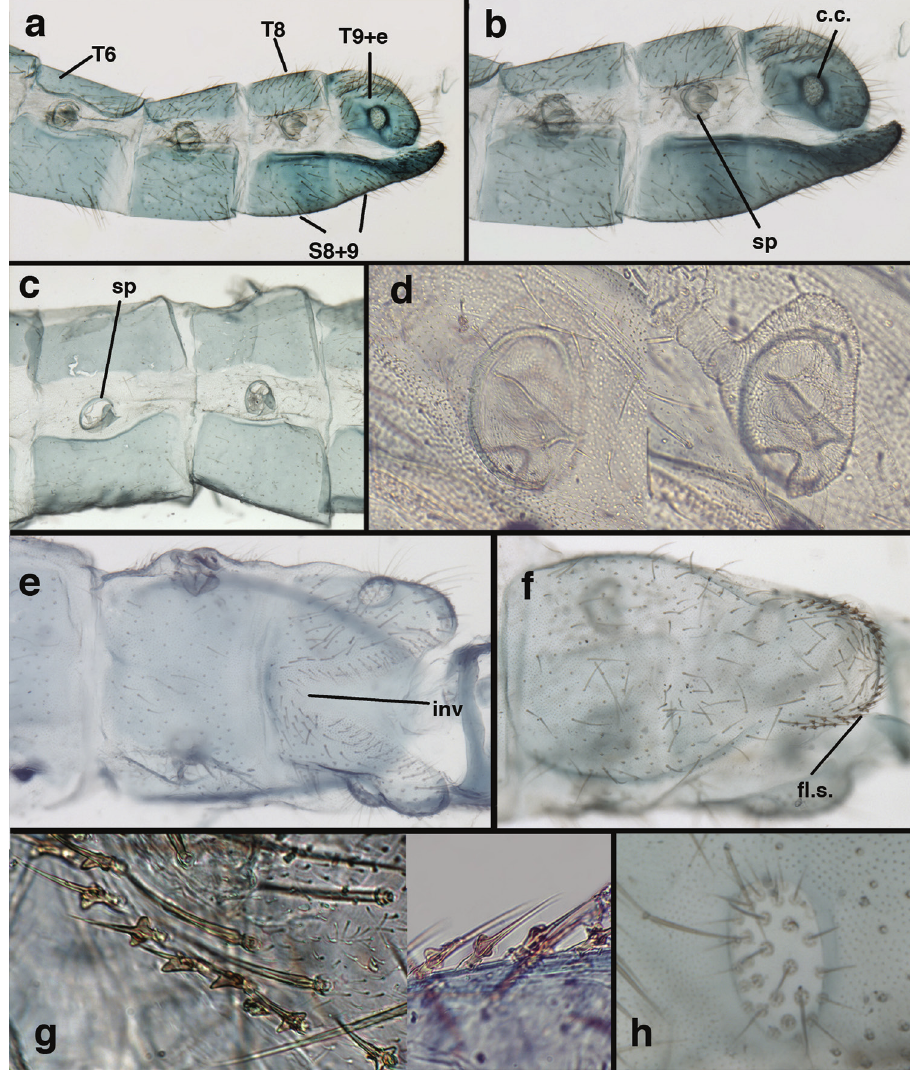
Figure 118. Ungla chacranella (Banks): Male abdomen, ( a ) segments A6-terminus, lateral ( b ) segments A7-terminus, lateral ( c ) segments A6 and A7, lateral ( d ) spiracle, left: opening on integumental surface, right: internal, immediately below integumental opening [Note enlarged flap.] ( e ) tergite T9 + ectoproct, dorsal ( f ) fused sternites 8+9, ventral, with robust, flanged setae along margin of S9 ( g ) enlarged, flanged setae on margin of S9, left, right ( h ) callus cerci. c.c. callus cerci fl.s. flanged setae inv distal invagina- tion of dorsal T9+ectoproct sp spiracle S8+9 fused eighth and ninth sternites T6, T8 sixth and eighth tergites T9+e ninth tergite + ectoproct (Argentina; a, b, g -right Mendoza, CAS; c, d La Rioja, FSCA; e Tucumán, USNM; f, g-left, h Salta,